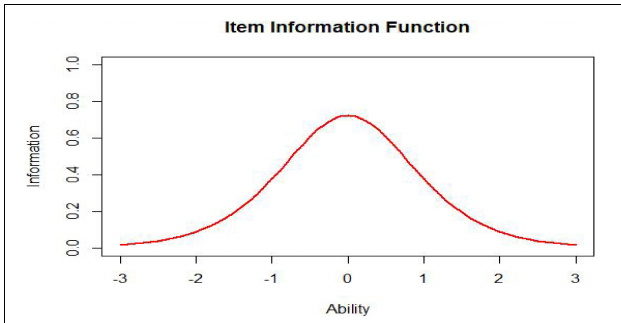
FIGURE 6 | Item information function ( a = 1, b = 0).